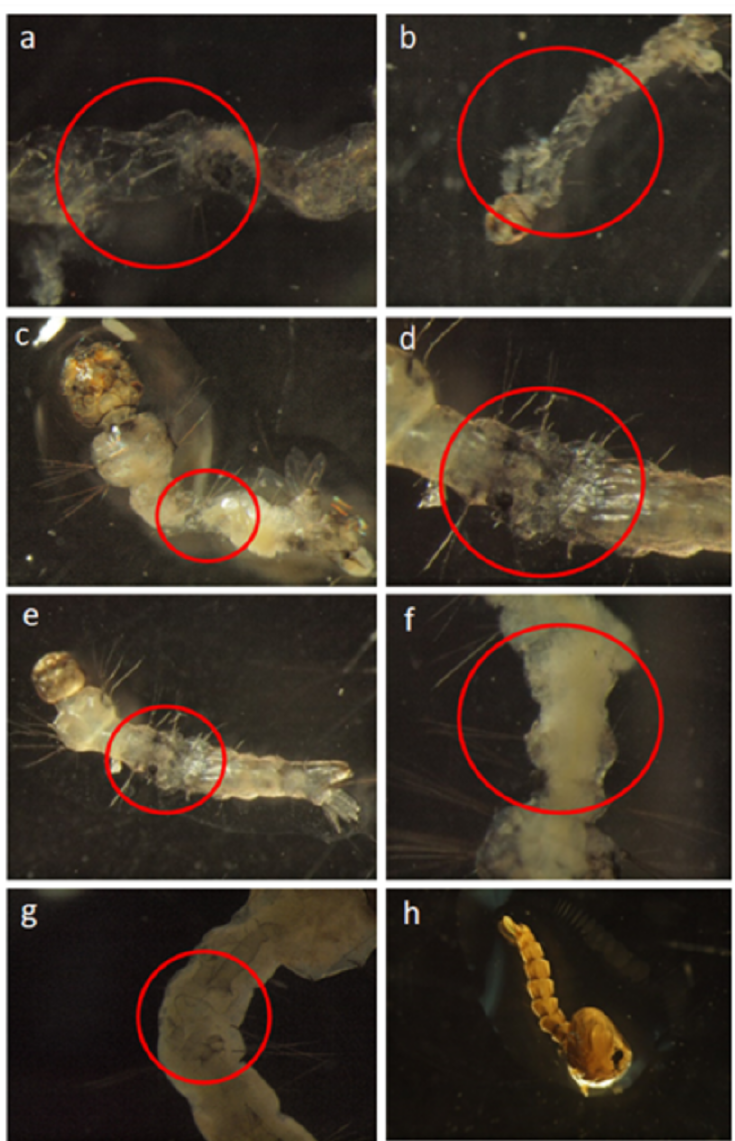
Figure 4. Post-treatment e ffi cacy of Larvasonic under laboratory conditions against larvae ( a – g ) and pupae ( h ) of Aedes